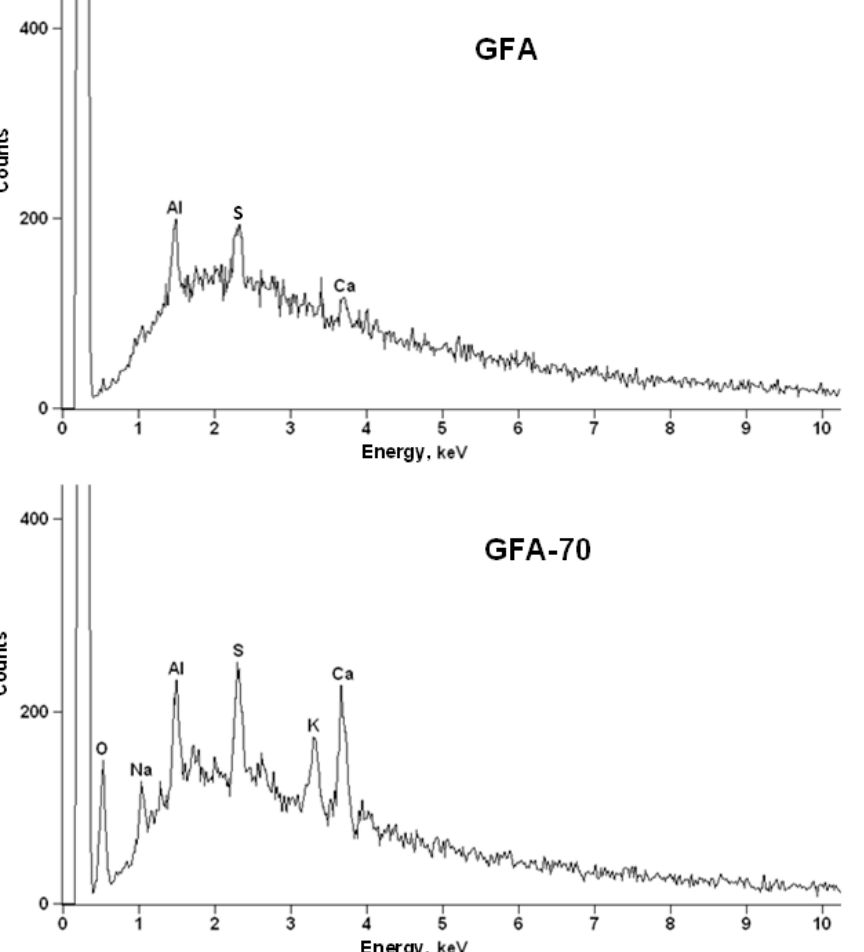
Figure 2. EDS spectra recorded for GFA and GFA-70 materials.